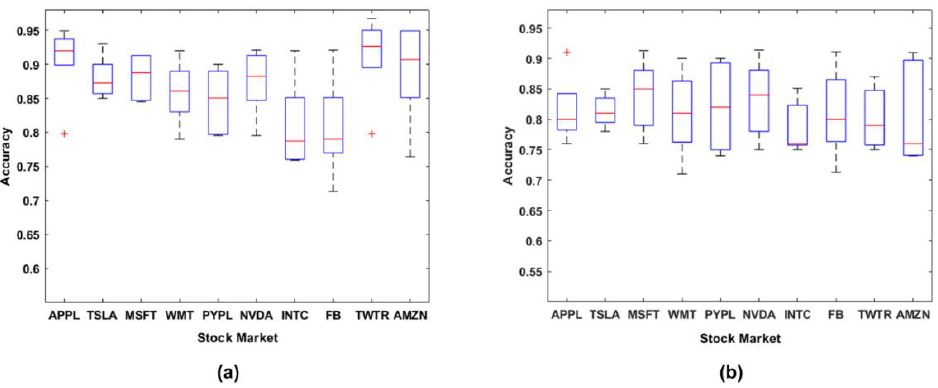
Figure 4. Accuracies of All brands using ( a ) ELM and ( b ) RNN.